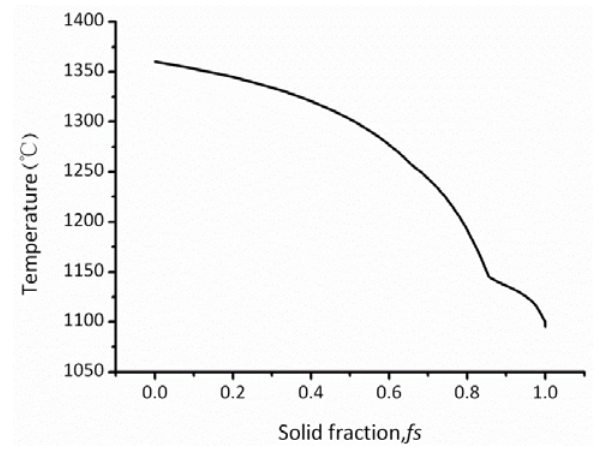
Figure 6. Solid fraction curve of the superalloy with temperature.